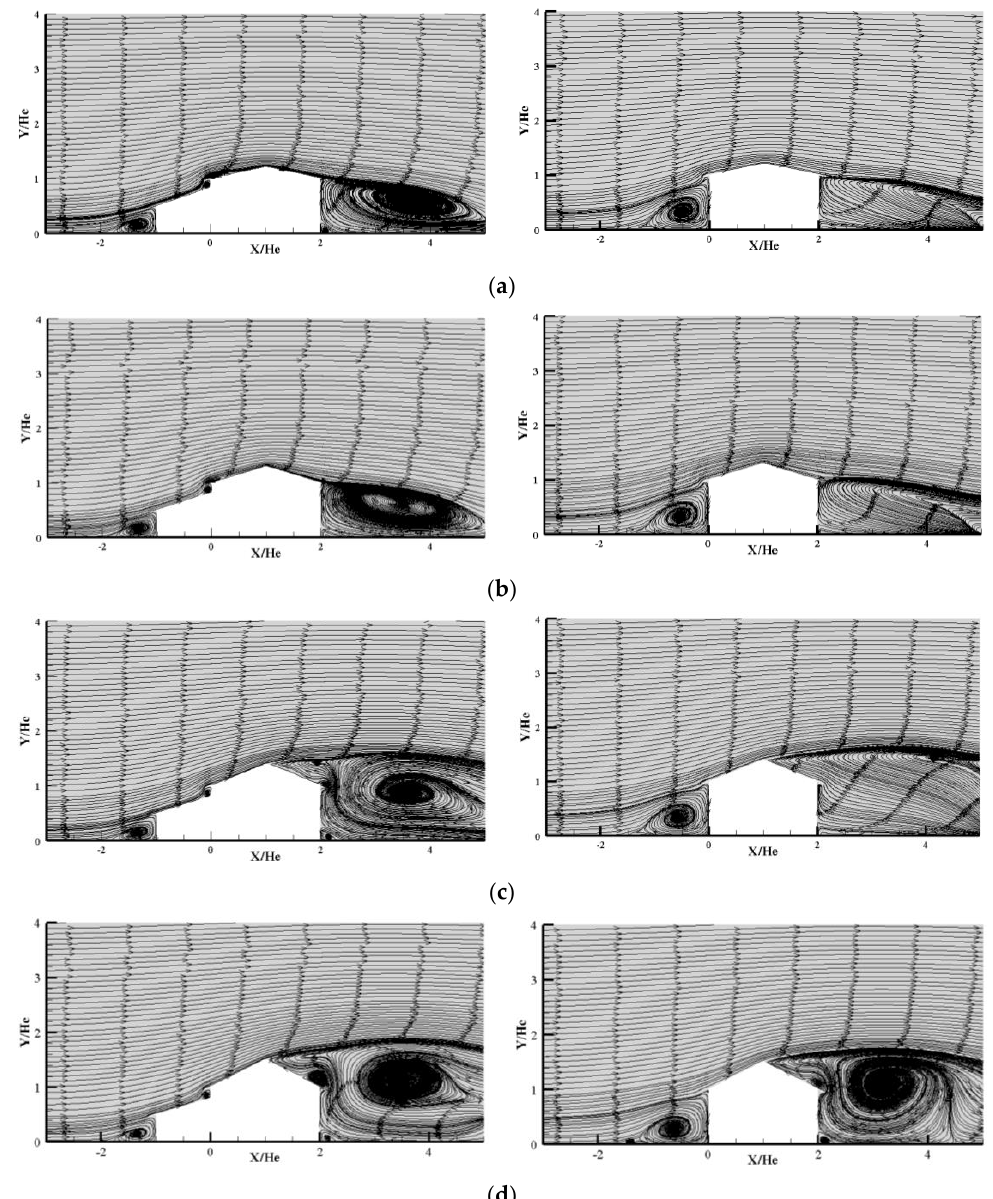
Figure 11. The streamline patterns with roof pitch ( a ) 12 ◦ ; ( b ) 17 ◦ ; ( c ) 22 ◦ ; and ( d ) 27 ◦ (note: right side = core house, left side = kitchen